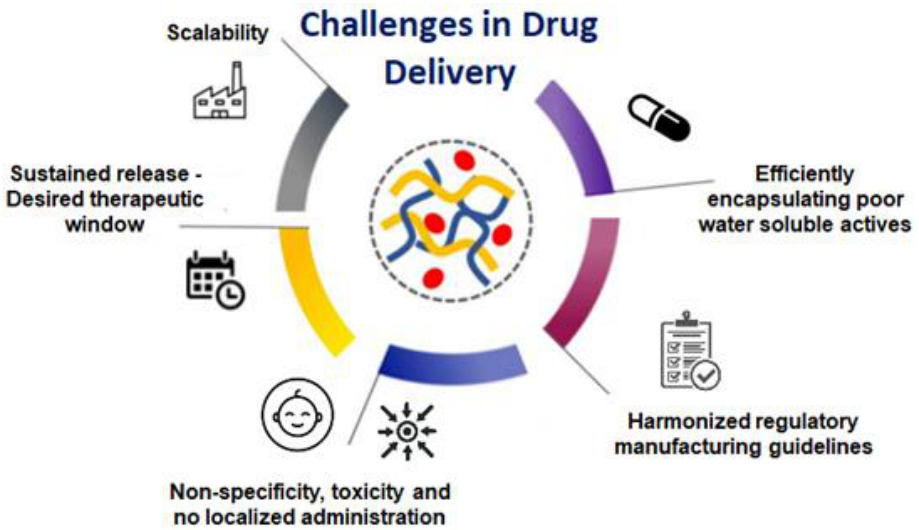
Figure 6. Pharmaceutical requirements. Examples of current challenges in drug delivery.